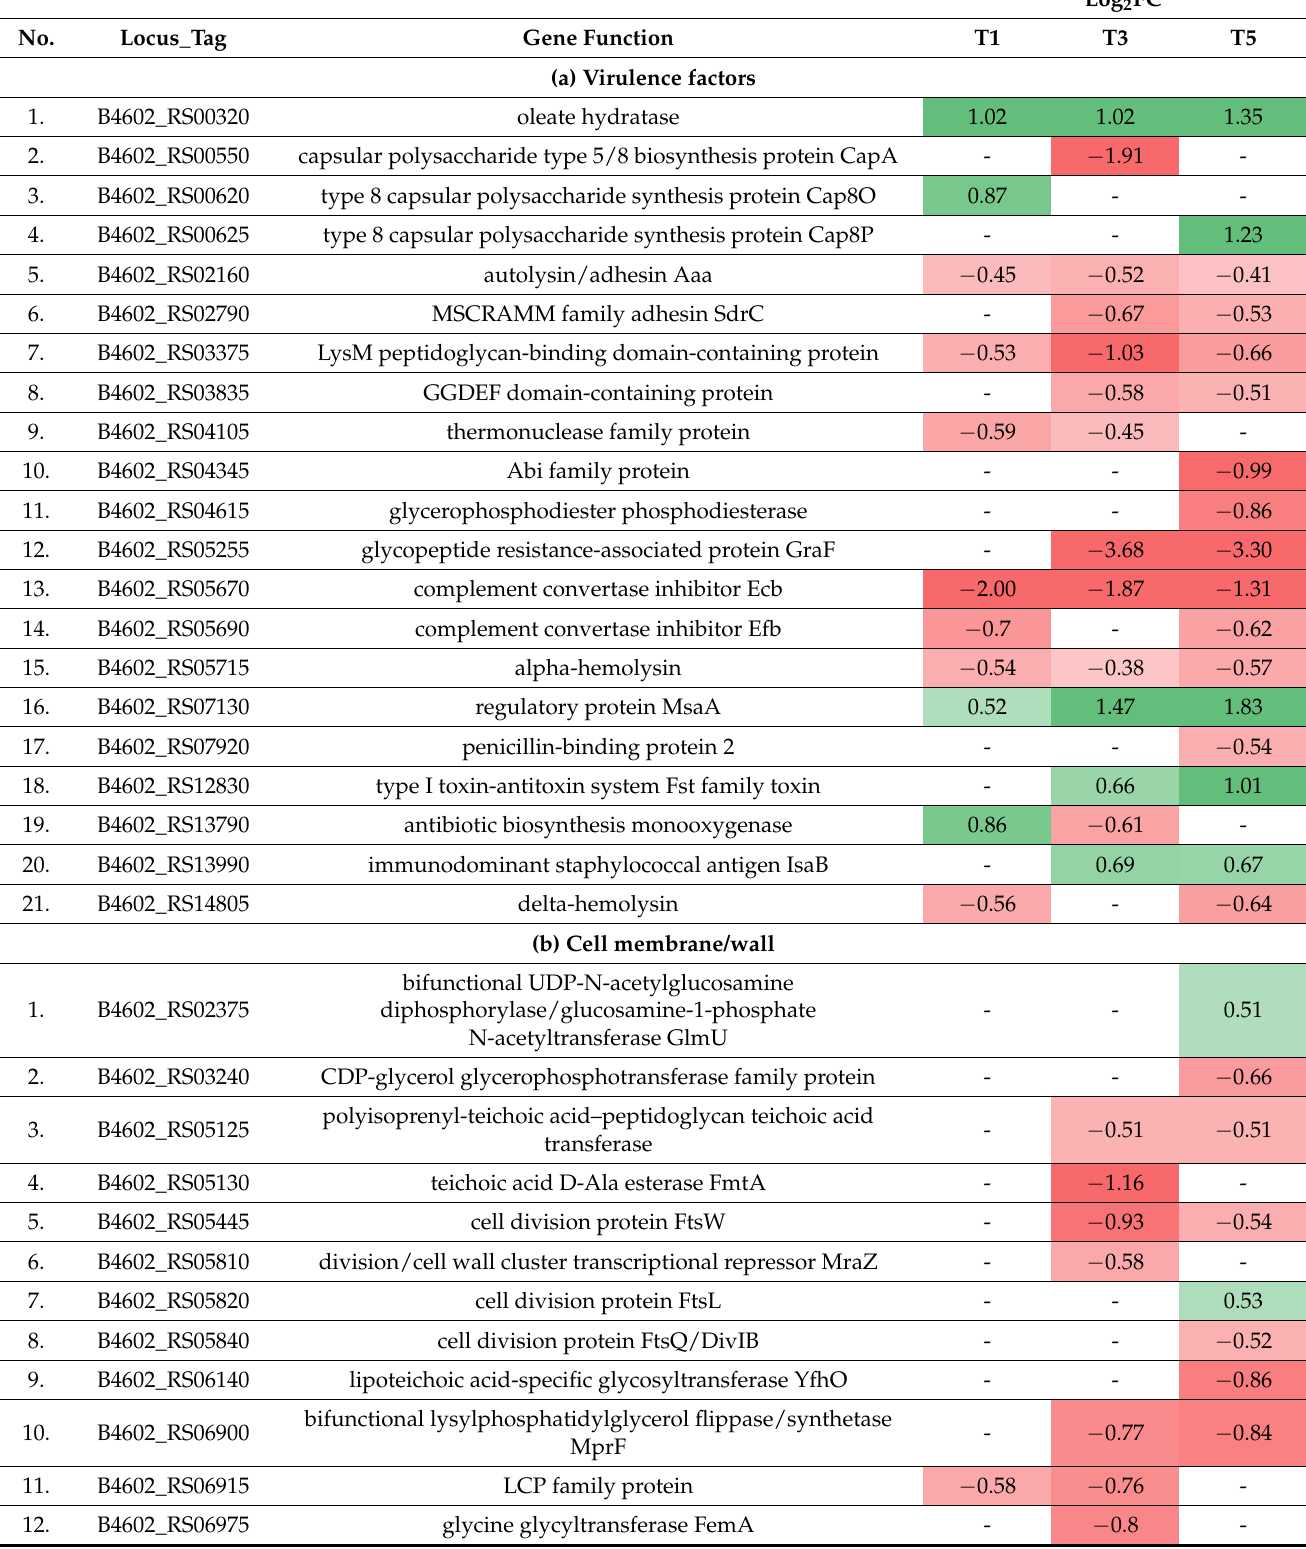
Table 3. List of DEGs related to various biological processes identified in T1, T3, and T5 treatments. The biological processes include (a) virulence factors, (b) cell wall and membrane, (c) transporters, (d) transcription, and (e)